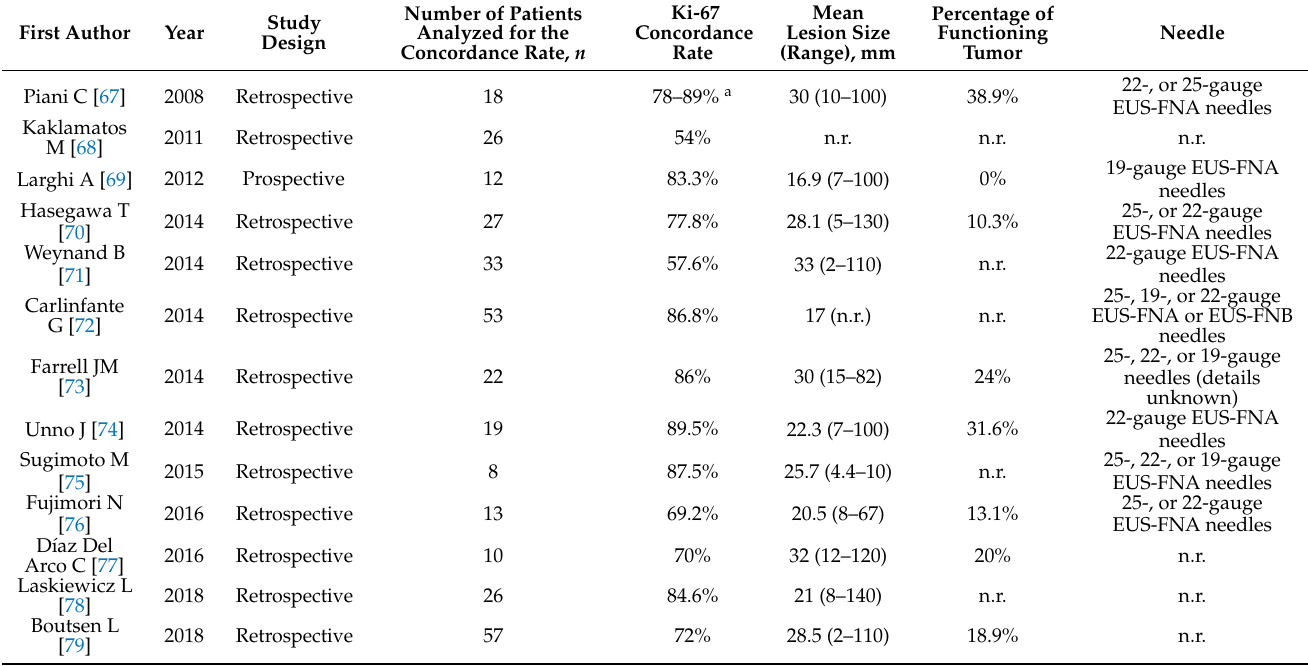
Table 2. Previous reports showing the concordance rates between EUS- fine-needle aspiration biopsy specimens and surgical